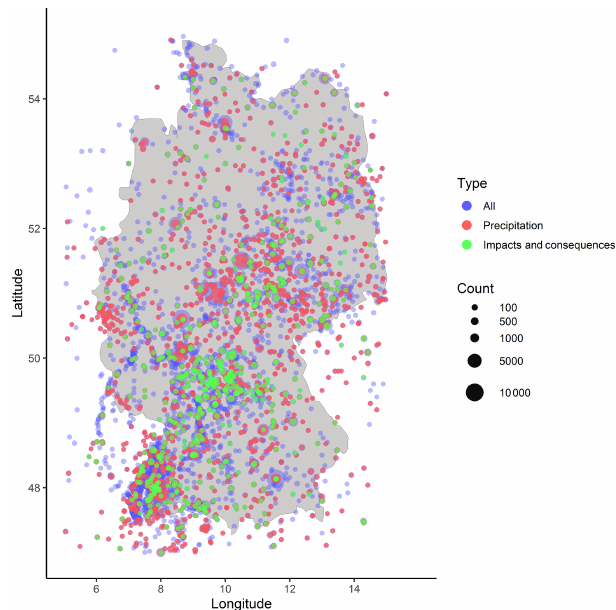
Figure 1. Spatial distribution of all records referring to Central Eu- rope from Tambora (tambora.org, 2018) since 1500 (blue), precip- itation, dryness and drought records (red), and impacts and conse- quences